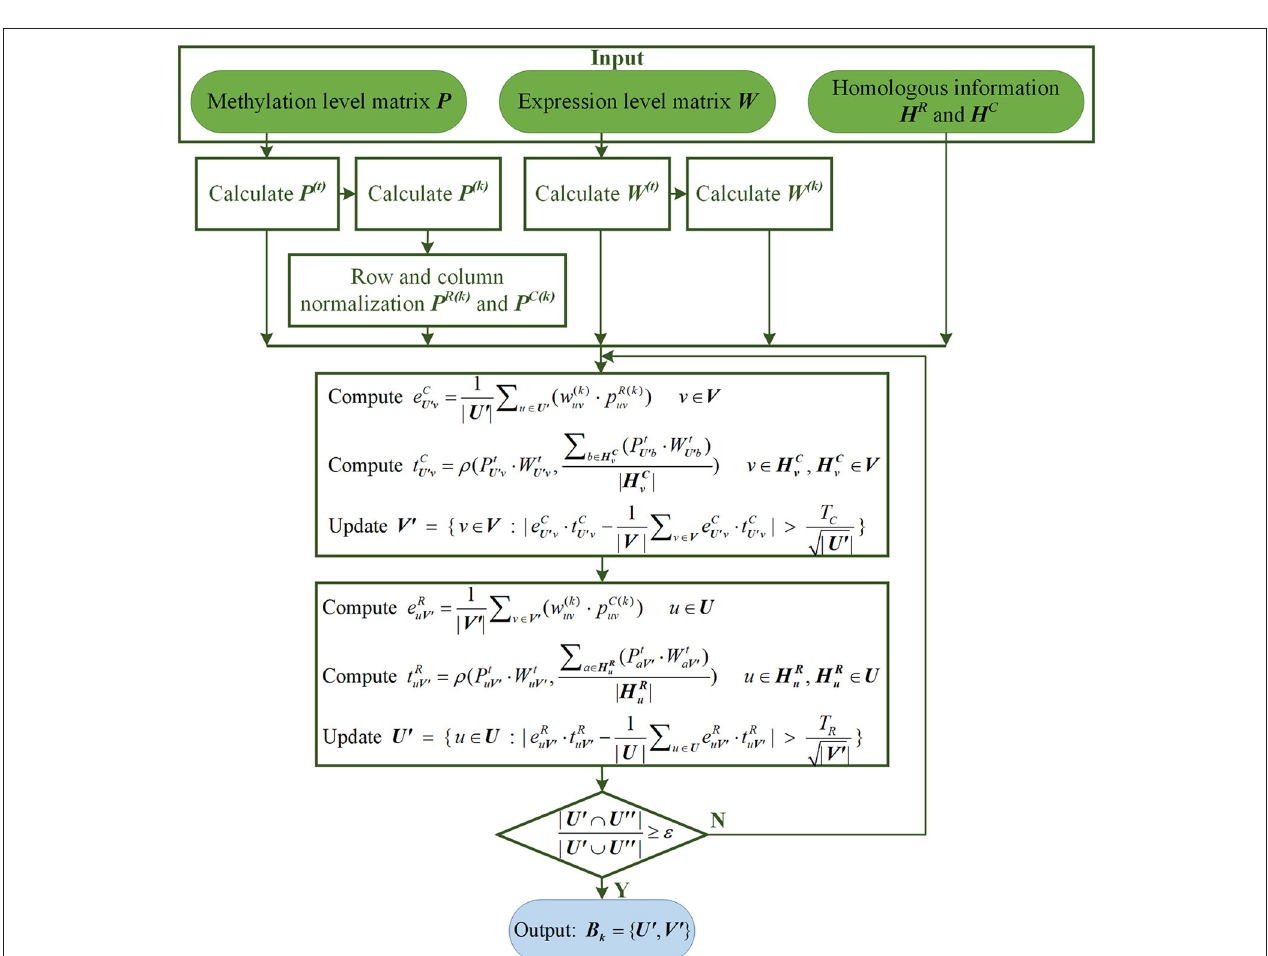
FIGURE 1 | The flow chart of searching for the k -th LFB by REW-ISA V2.